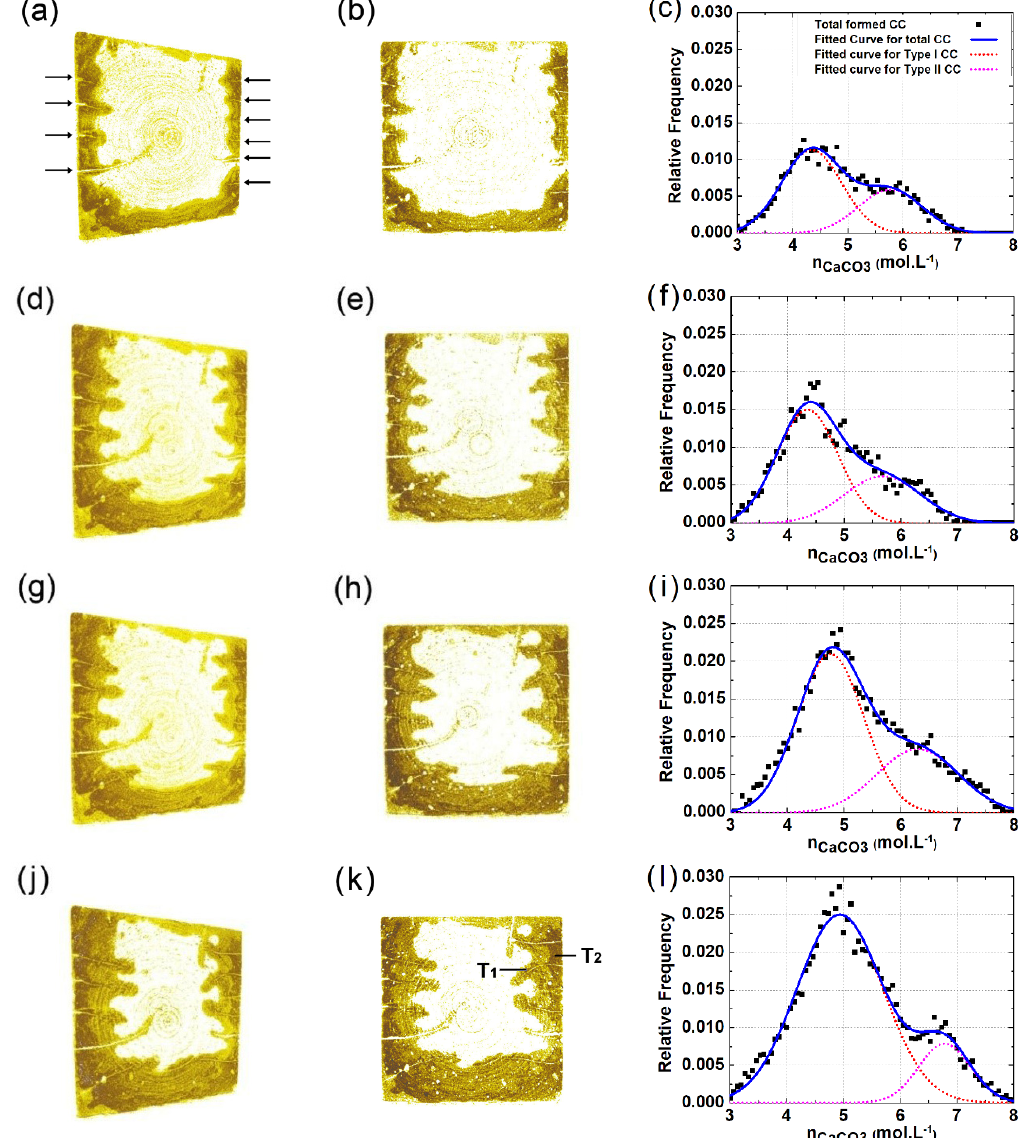
Figure 6. Spatial and frequency distribution of CC(cid:3364) for sliced sample: ( a , d , g , j ) show the 3D map of CC(cid:3364) content after 3, 7, 14, and 28 days of carbonation, respectively; ( b , e , h , k ) show the 2D map of CC(cid:3364) content after, 3, 7, 14, and 28 days of carbonation, respectively; ( c , f , i , l ) show the histograms on local CC(cid:3364) content based on the related 2D map on its left.